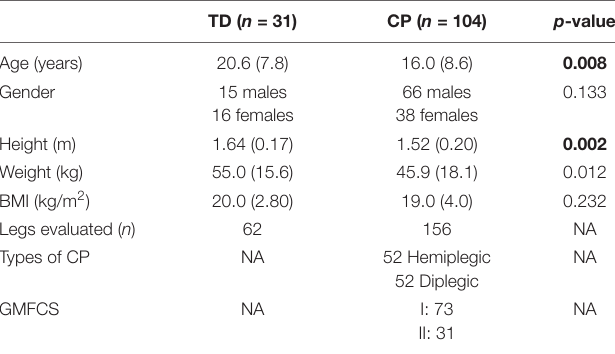
TABLE 1 | Descriptive statistics of the participants (independent samples T -test, chi-square test for